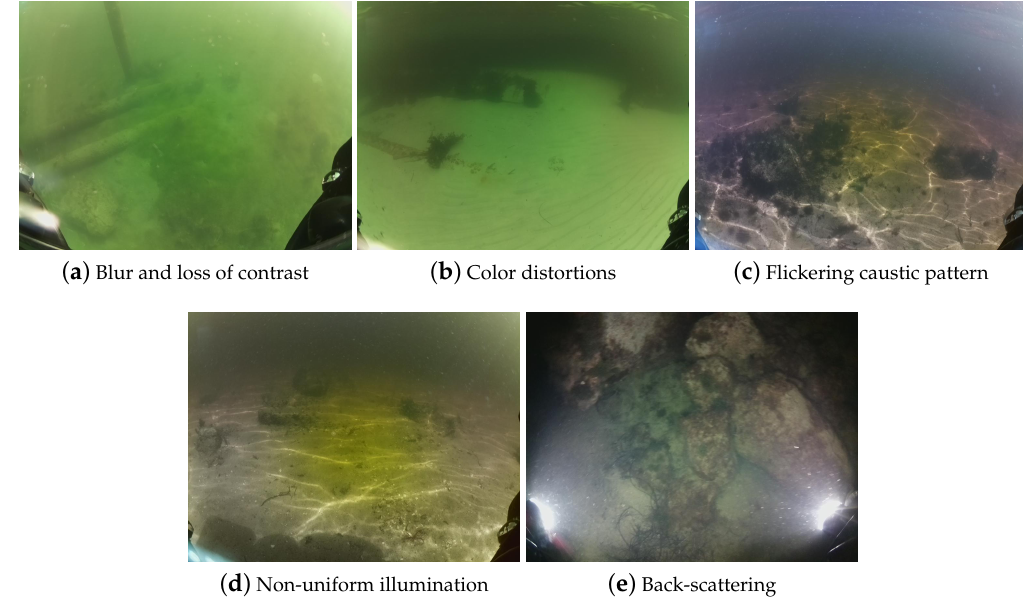
Figure 2. Lighting effects on underwater